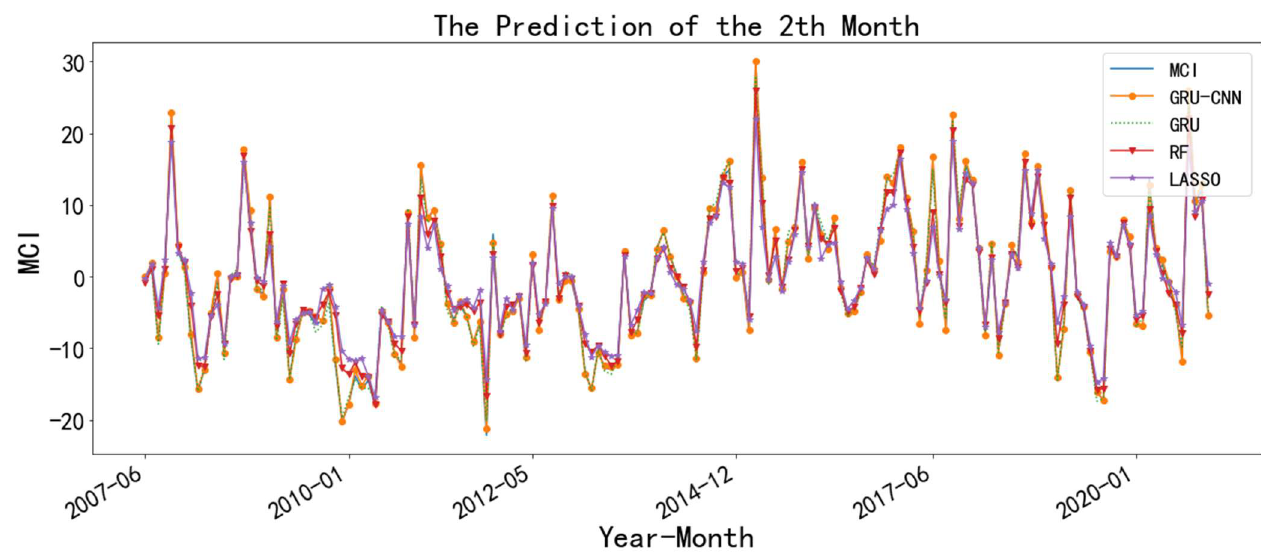
Figure 8. The prediction of the MCI at the Lincang station with 2-month leading.